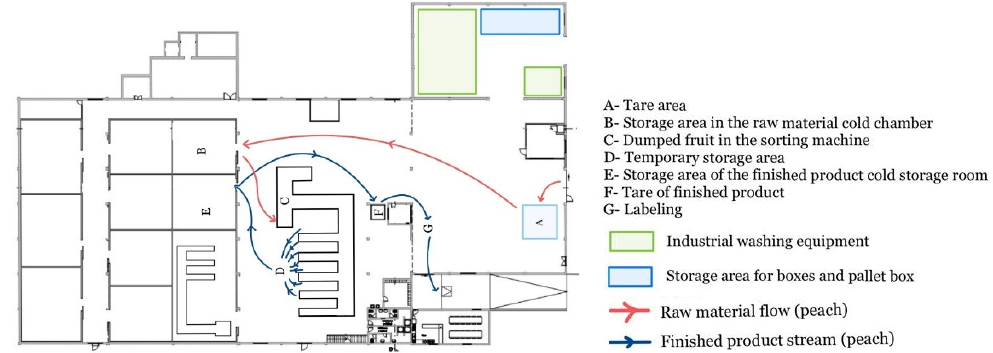
Figure 8. Current layout with proposals for improvement.